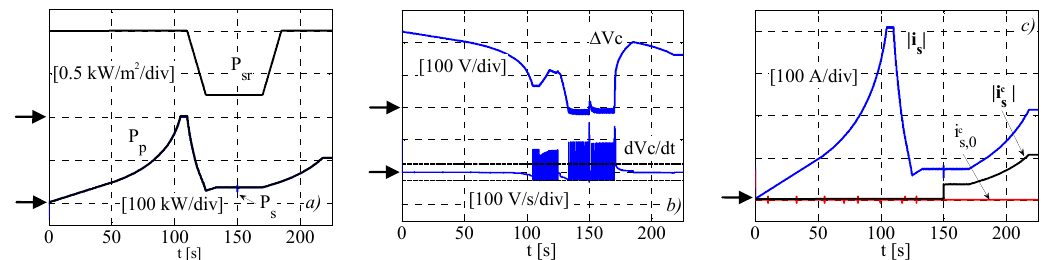
Figure 7. Main electrical quantities during the whole time window: ( a ) grid and PV Powers and solar irradiation; ( b ) capacitor voltage and time derivative; ( c ) space vectors modules of grid current and converter common mode current with homopolar component.